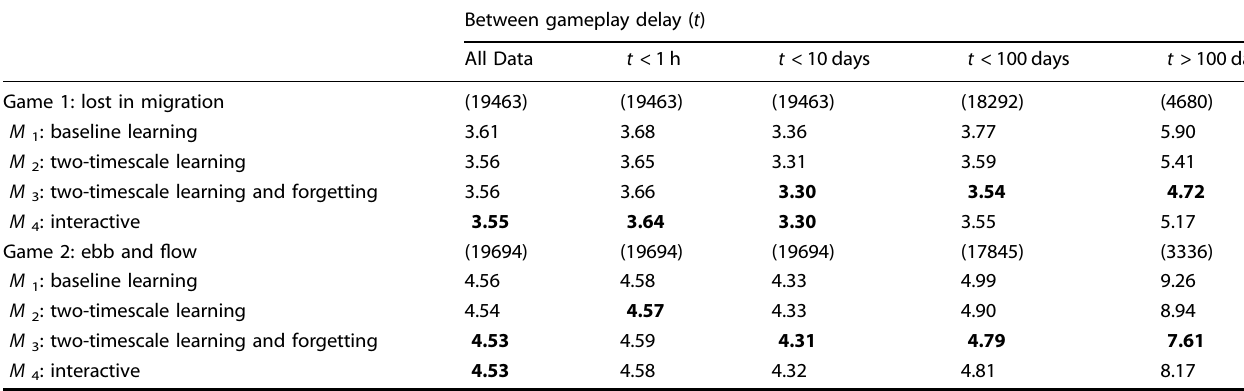
Table 1. Predictive performance of the models assessed by root mean squared error (RMSE) on out-of-sample data. Numbers in parentheses show number of participants in the evaluation. Best performing models for each game and data subset are highlighted in bold. Between gameplay delay ( t